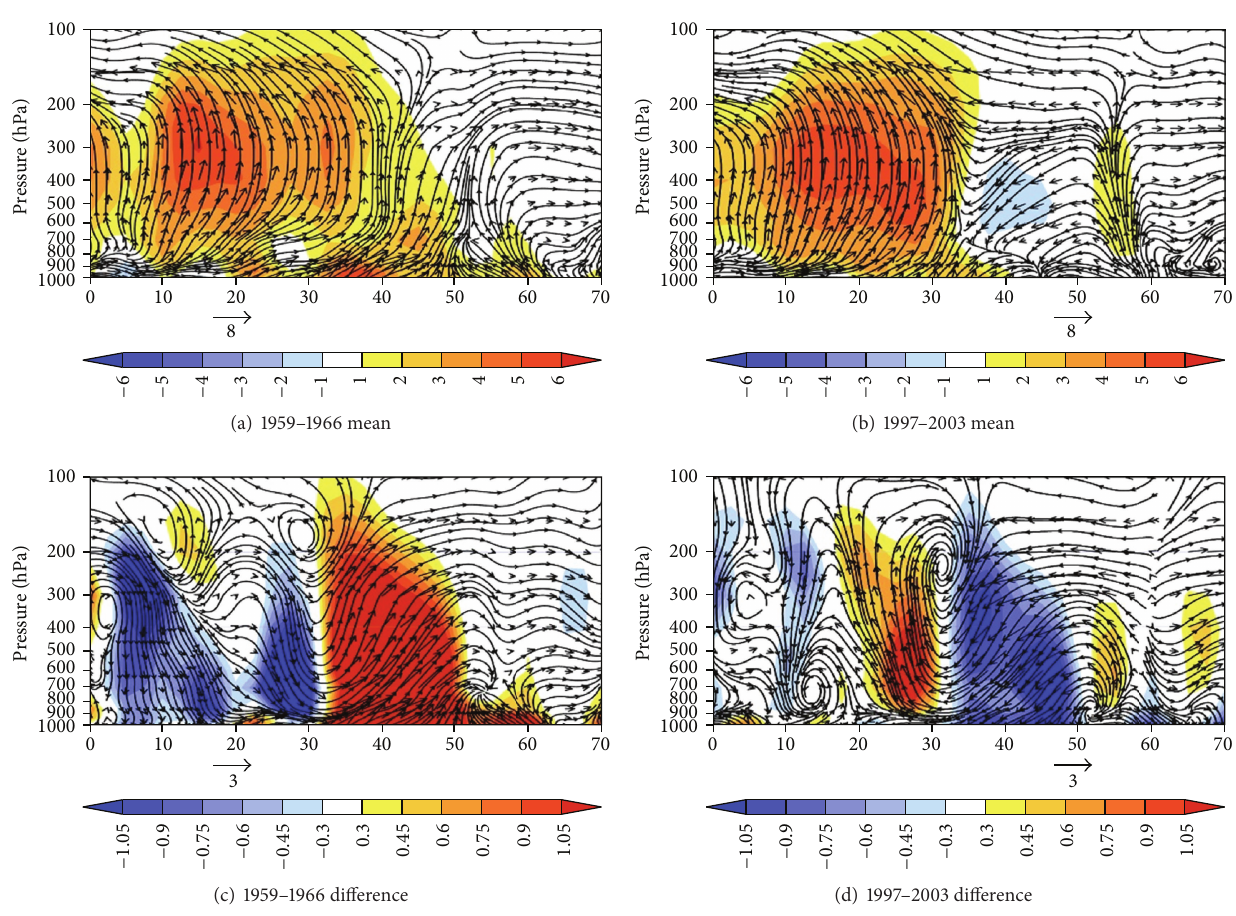
Figure 8: The mean and difference of meridional circulation cells averaged over 105–120 ∘ E. The mean for the periods of (a) 1959–1966 and (b) 1997–2003, (c) the difference between 1959–1966 and 1958–2010, and (d) the difference between 1997–2003 and 1958–2010 (unit: 0.1